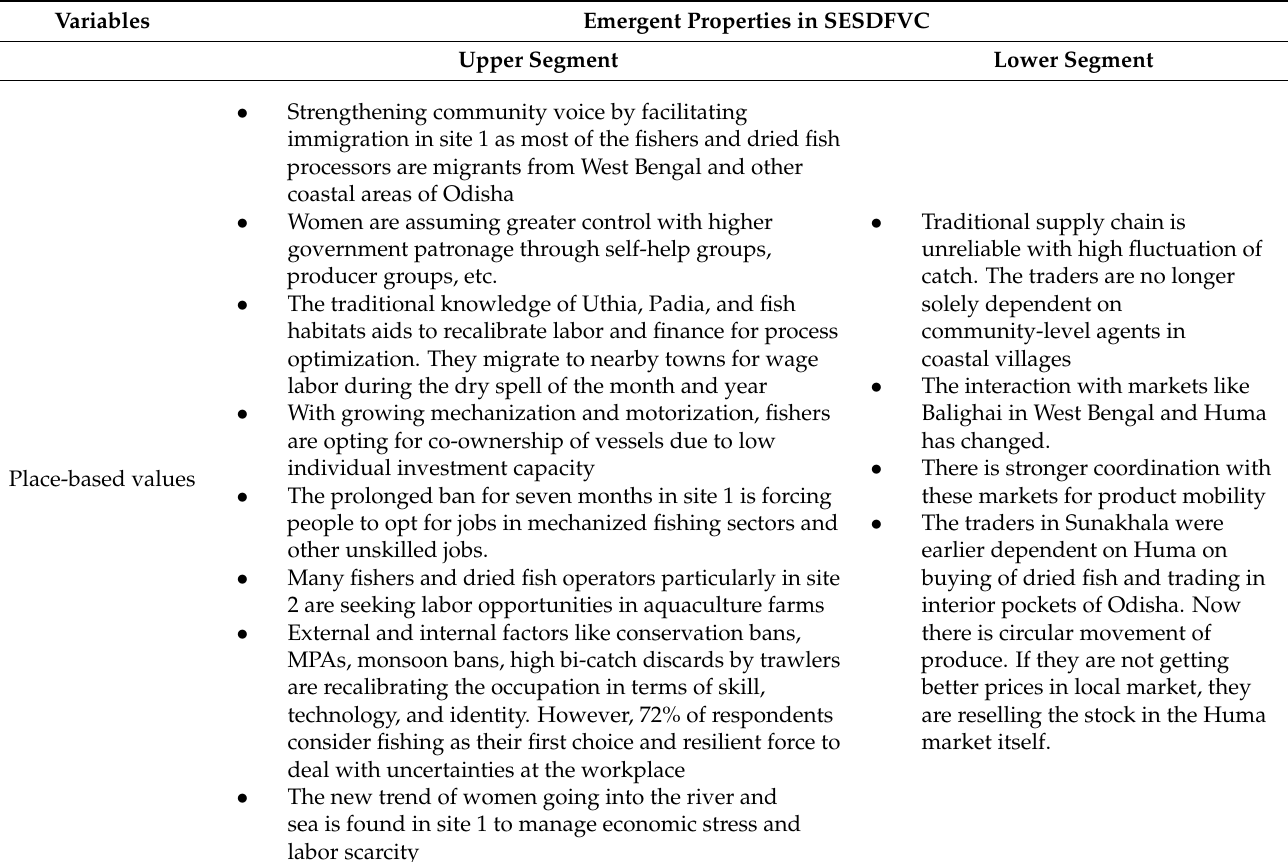
Table 9. Place-based values and dimensions of emergence in